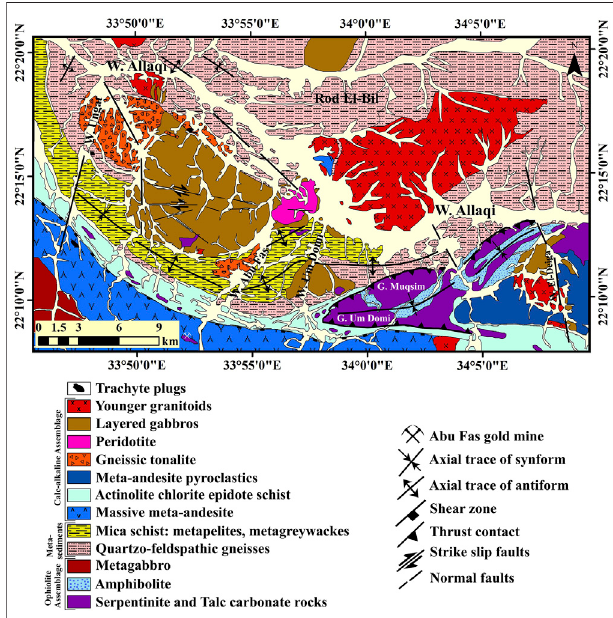
FIGURE 10 | Geological map of Moqsem-Ungat area (modi fi ed after Sadek, 1995) showing the c. E-W trending folds and thrusts.